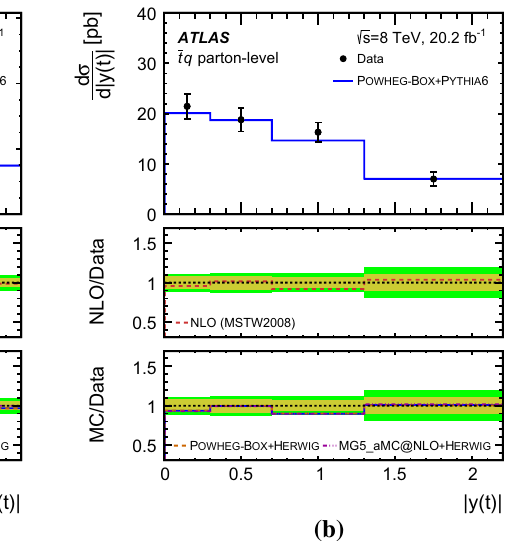
data with the MC predictions from Powheg - Box ( orange dashed line ) and MadGraph5 _aMC@NLO ( purple dash-dotted line ). The inner ( yellow ) band in the bottom part of each figure represents the statistical uncertainty of the measurement, and the outer ( green ) band the total uncertainty